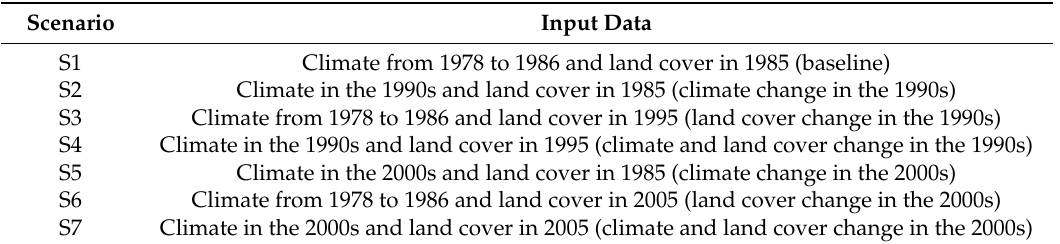
Table 8. Input data for the seven scenarios.